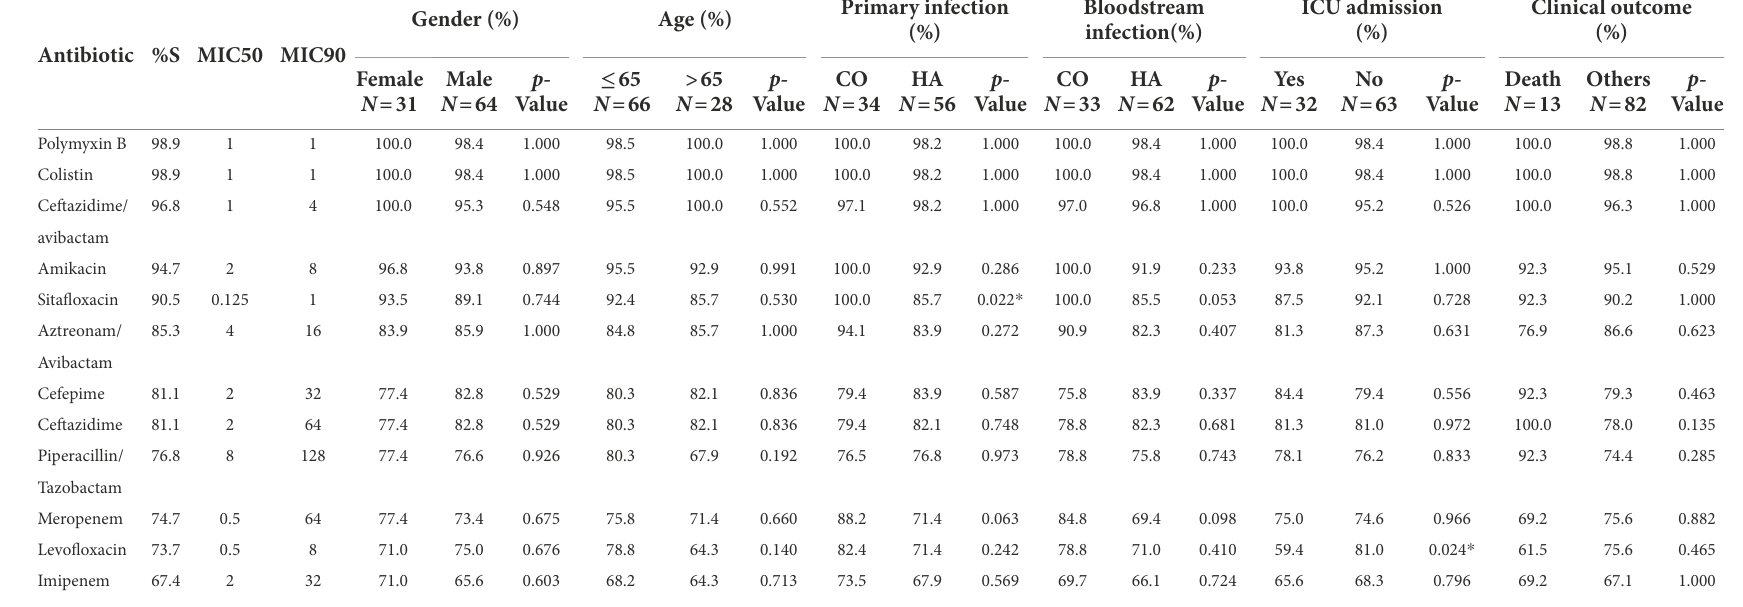
TABLE 3 Comparison of the antimicrobial susceptibility rates of P. aeruginosa isolates in clinical features.